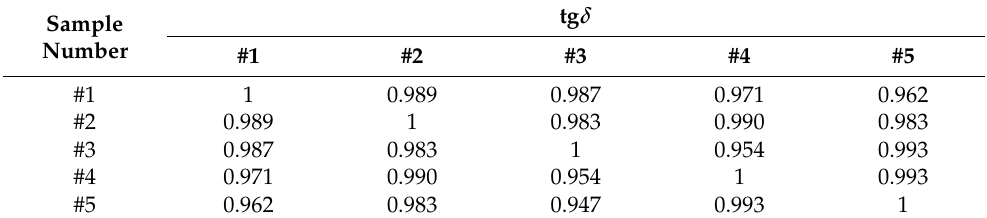
Table 5. Pearson’s coefficient for tg δ in the 1 MHz to 3 GHz